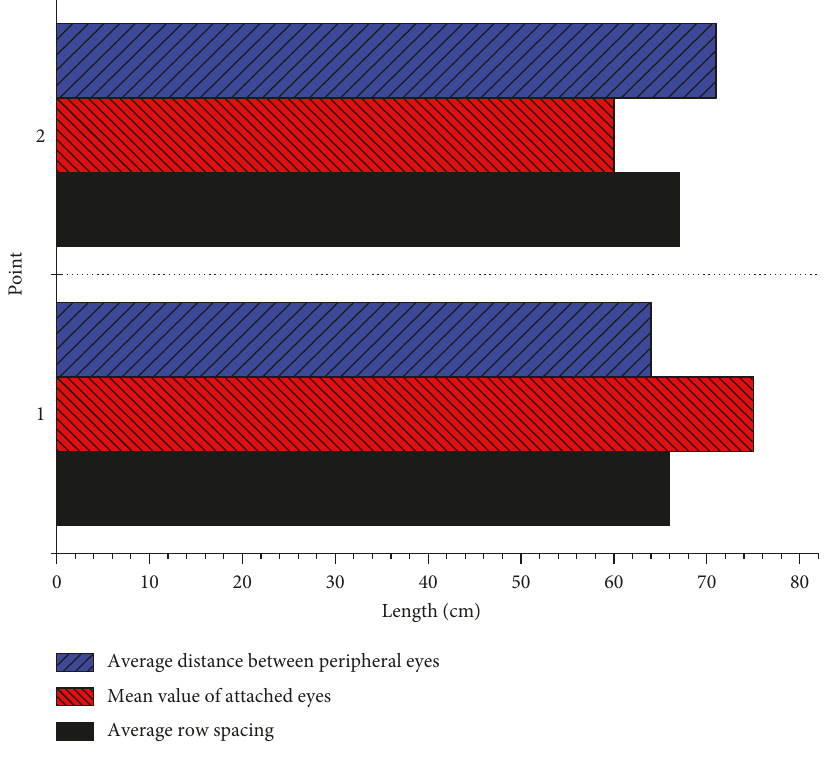
Figure 10: Optimal drilling and blasting process